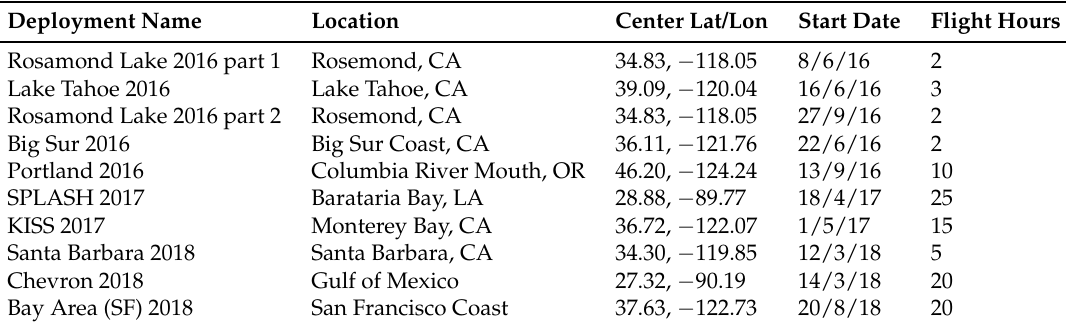
Table 3. DopplerScatt deployments at of the time of